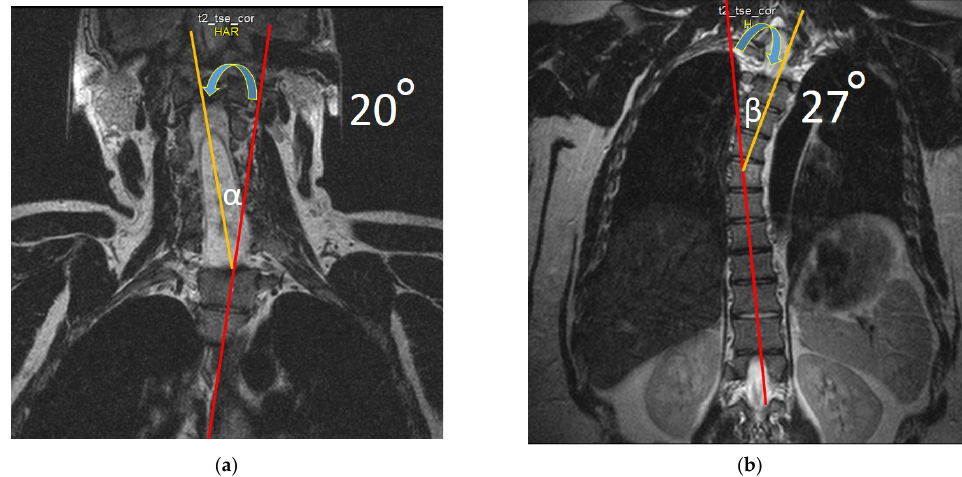
Figure 7. T2-weighted MRI scan of the cervical ( a ) and thoracic spine ( b ) demonstrate scoliosis at the cervicothoracic level. Note: Red lines are drawn along the axis of the spine; yellow lines are drawn by the deviated part of the spine from the axis of the spine; blue arrows indicate the direction of curvature. In degrees, deflection angle in the cervical region ( α ) and in the thoracic region ( β ) is determined.